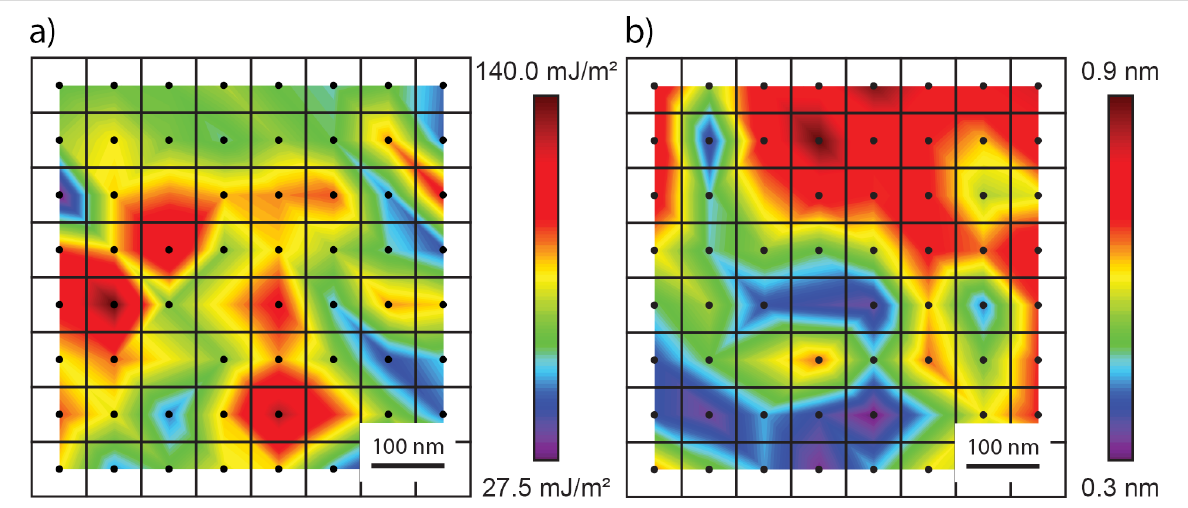
Figure 6: a) Averaged best-fit W adh value over a 500 nm × 500 nm scan area of the diamond surface. b) Averaged best-fit z 0 value over a 500 nm × 500 nm scan area of the diamond surface. There are four positions in this scan area for which all frequency curves were disregarded as the extracted F ( z ) curves contained multiple local force